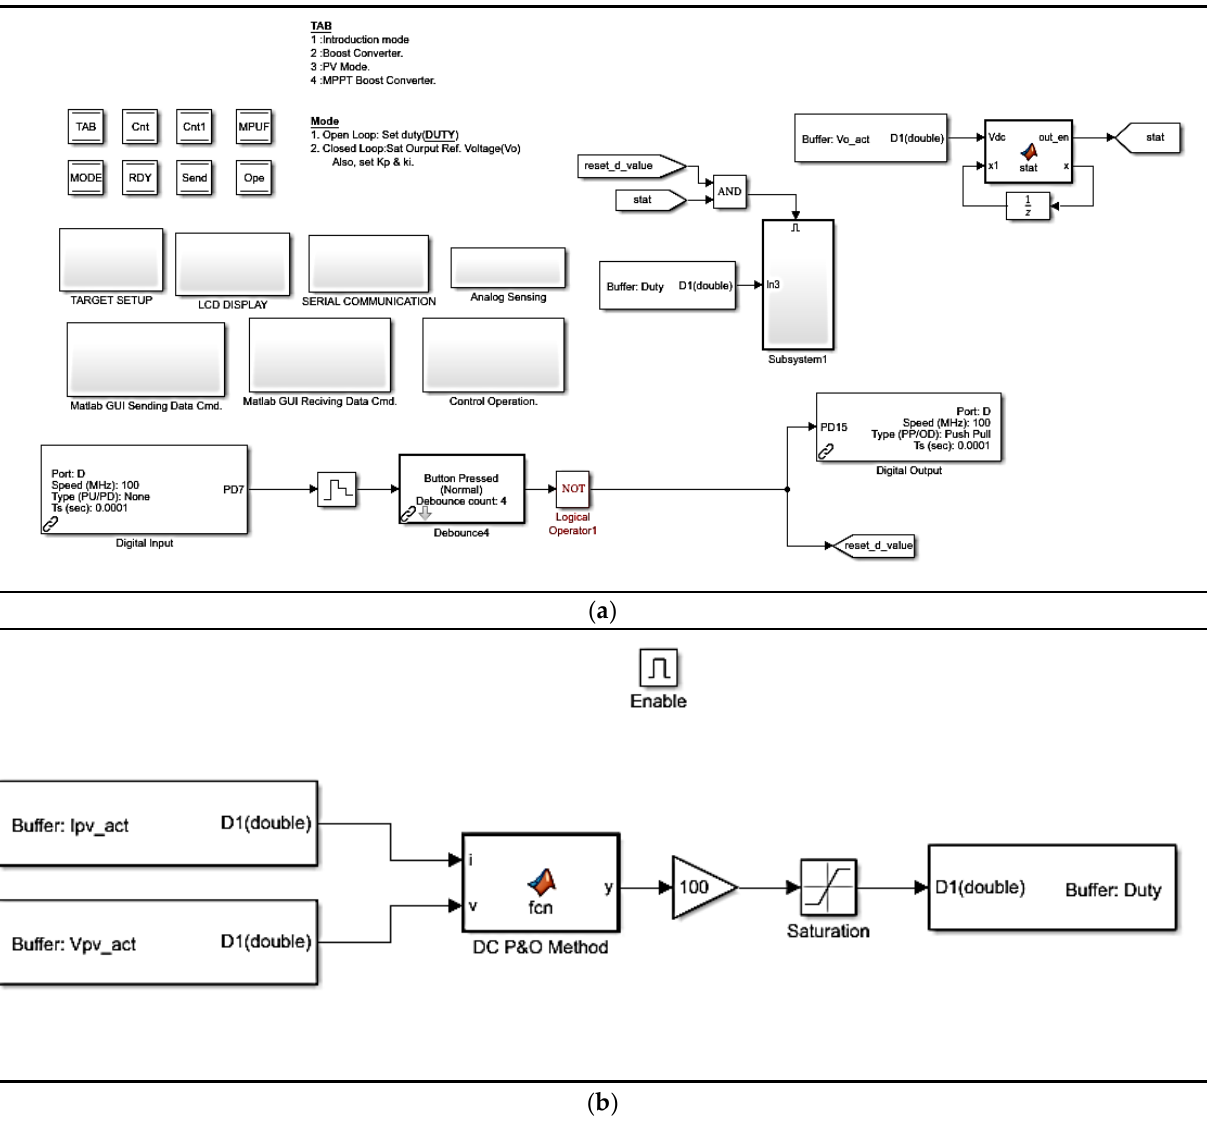
Figure 14. MPPT tracking under partial shading: ( a ) detailed block set and parameter values of 32-bit ARM Cortex M4 (STM32F407VGT6) Microcontroller; ( b ) implementation of DC-(P&O) method in MATLAB with code generated in ( a ).